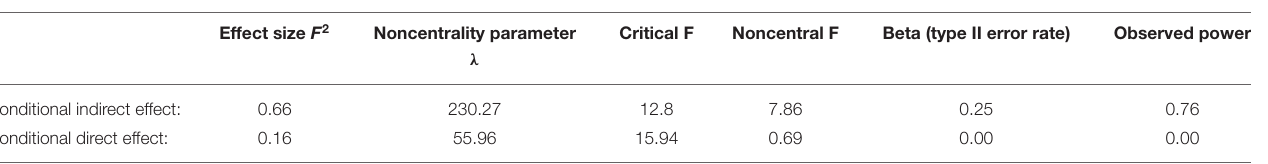
TABLE 10 | Moderation model power